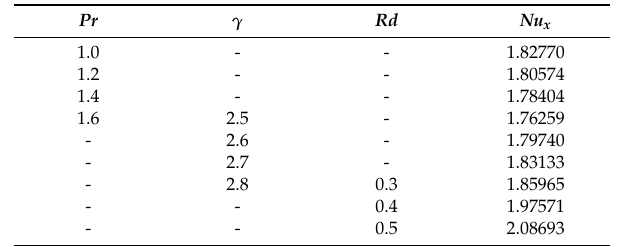
Table 2. The numerical values of heat flux τ = π